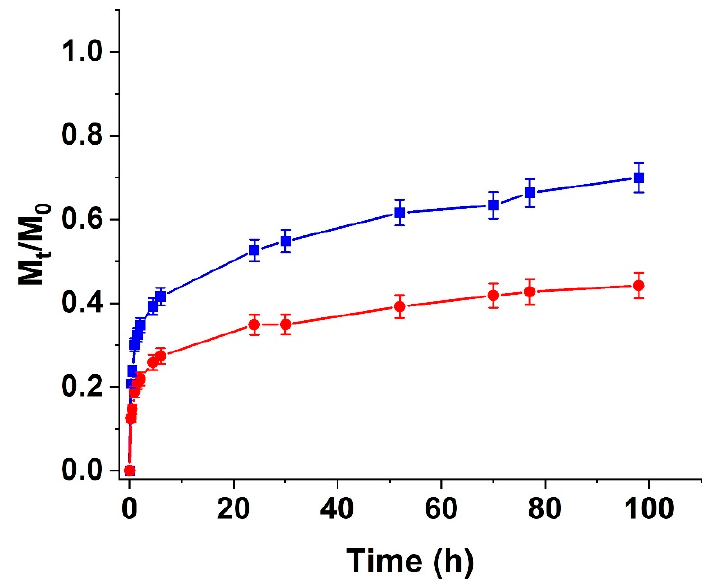
Figure 10. CUR release from H ALG (blue line) and H ALG-GO (red line) as a function of time. The CUR-to-hydrogel ratio (by weight) was 2.5%.